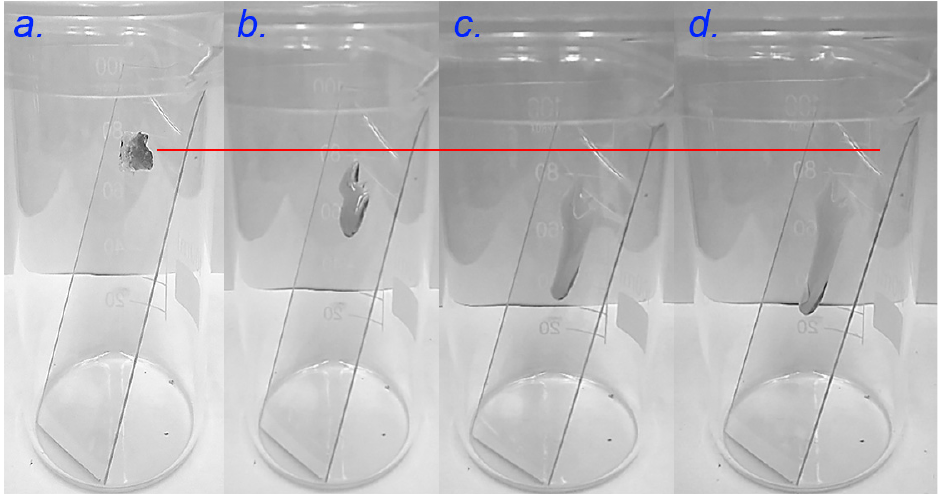
Figure 4. PBS sample placed on an inclined slide glass at different time intervals: after 1 day ( a ), 3 days ( b ), 6 days ( c ), 8 days ( d ).